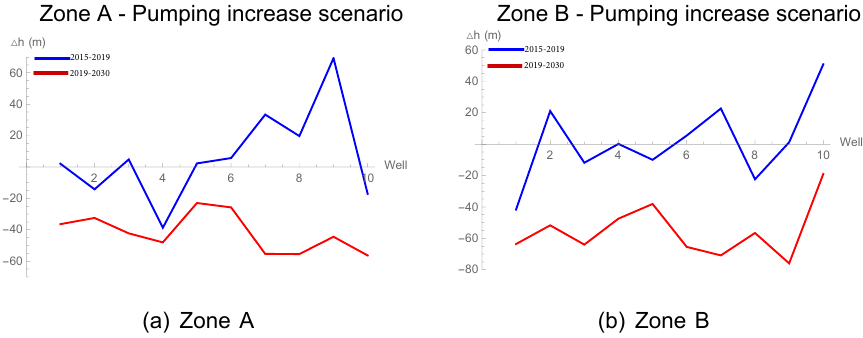
Figure 20. Variation of the hydraulic head in the pumping increase scenario of the dry season. Figura 3.8: Variaci´on de la carga hidr´aulica en el escenario Aumento de Bombeo de la Temporada de Secas.